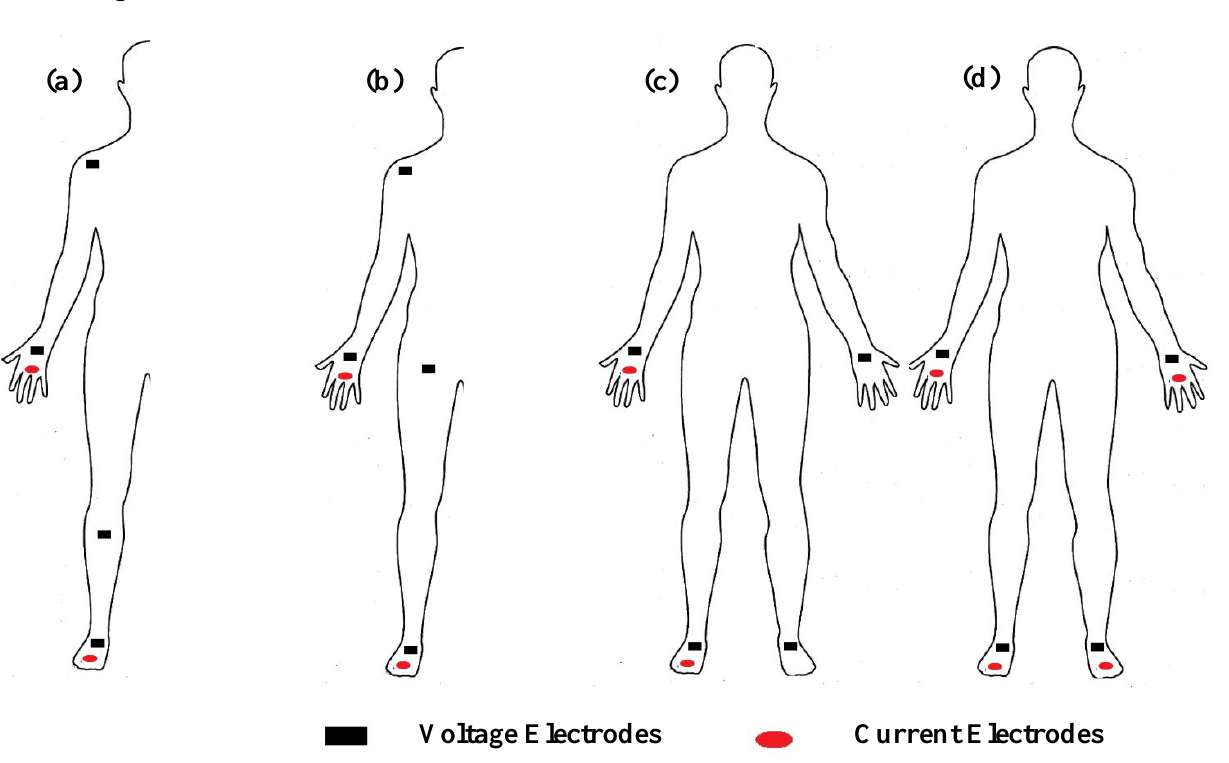
Figure 4. Segmental bioimpedance analysis techniques, ( a ) right side dual current and quad voltage electrodes, ( b ) right side dual current and quad voltage electrodes, ( c ) double sides dual current and quad voltage electrodes and ( d ) double sides quad current and quad voltage